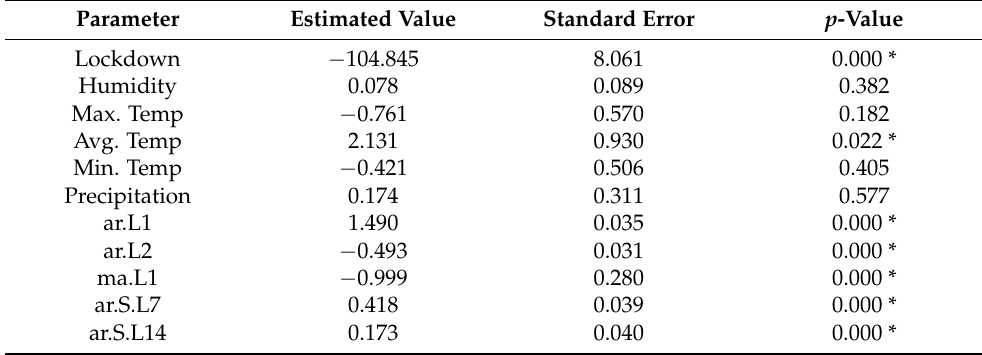
Figure A1. The loss function for ED patient arrival of the best LSTM: ( A ) univariate and ( B ) multivariate. Table A2. Parameter estimates for SARIMAX (2, 0, 1)(1, 0, [])7 with a one day forecast horizon.